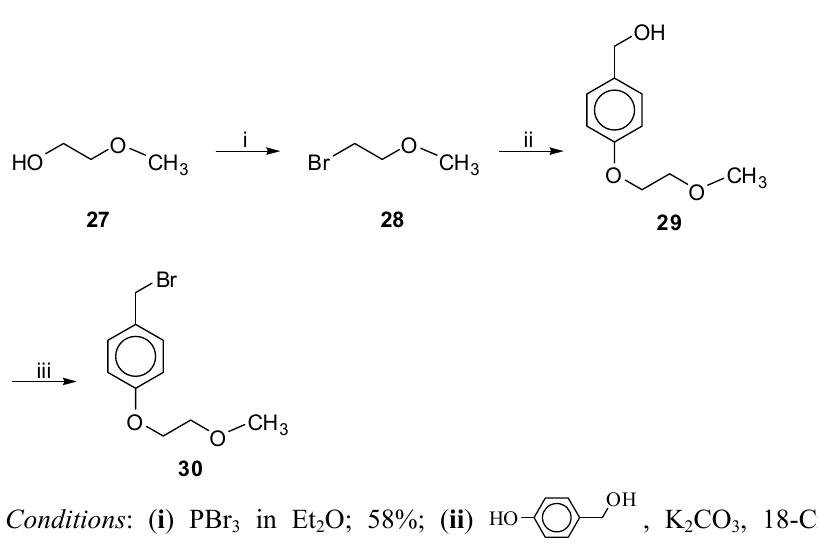
Scheme 4. Synthesis of bromide 30